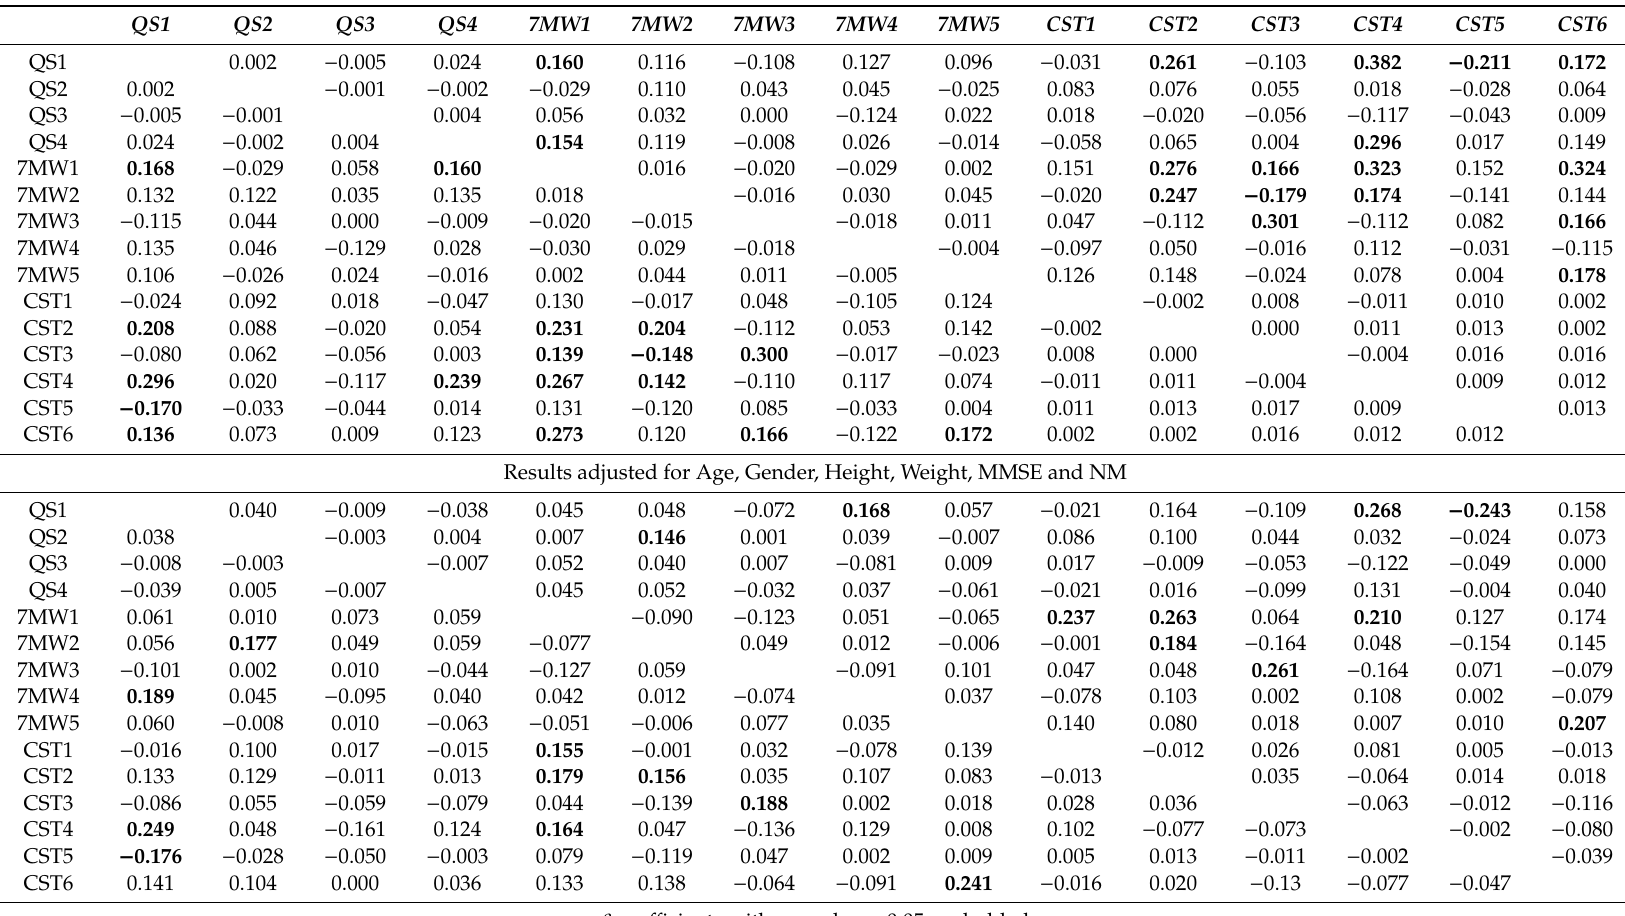
Table 8. Construct validity analysis: Linear regression between